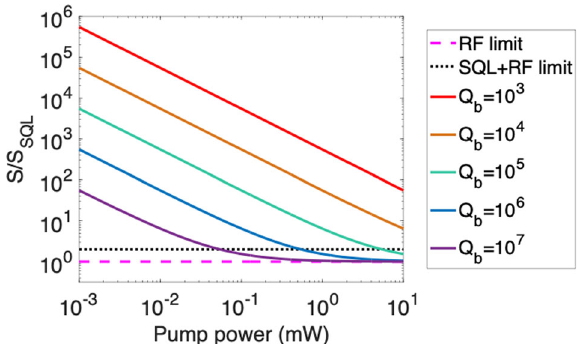
Fig. 7 High-ef fi ciency transducer for high-precision microwave measurement. Noise spectral density (S) normalized by the standard quantum limit (SQL) as a function of the pump power, with back- action noise cancellation. The parameters follow our transducer design, except that the optical Q factor is chosen to be 10 8